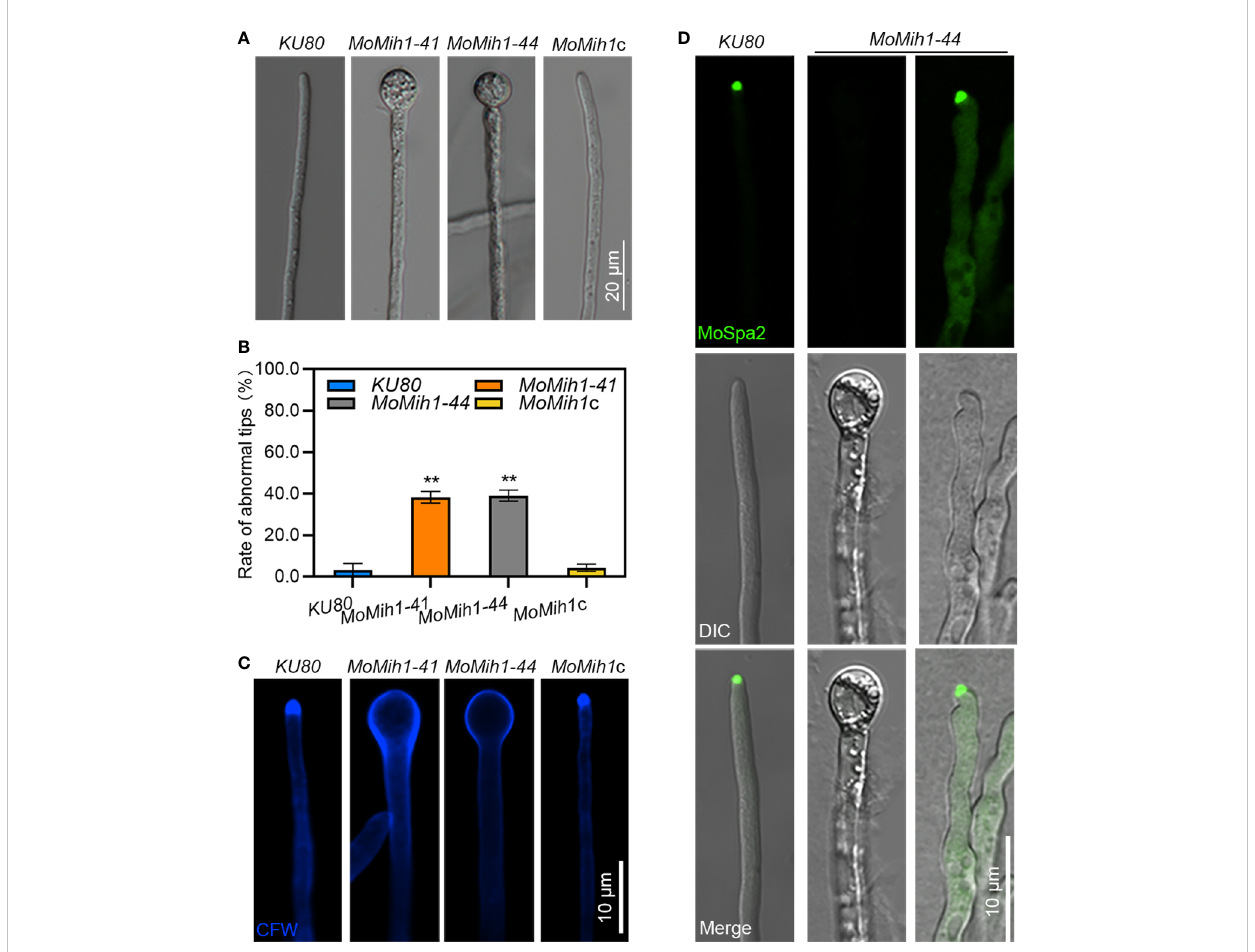
FIGURE 8 MoMih1 is required for polarized growth of M. oryzae (A) Deletion of MoMih1 resulted in the development of swollen structures at the mycelia tips. All tested strains were inoculated in liquid CM at 28°C for 48 h in darkness, and then swollen structures at the mycelia tips were photographed Bar = 20 m m. (B) Statistical analysis of abnormal structures at the mycelial tips. The rate of abnormal mycelial tips was recorded and statistically analyzed. The error bars represent the SD of three replicates, whereas “ ** ” represents a signi fi cant difference ( p < 0.01). (C) Chitin distribution on the cell wall of mycelial tips. Hyphal tips of the tested strains were stained by CFW and observed by confocal microscopy. Chitin distribution was abnormal at the swollen tips of the MoMih1 mutant. Bar = 20 m m. (D) Localization of MoSpa2-eGFP in the MoMih1 mutant. Hyphal tips of KU80 and MoMih1-44 that expressed MoSpa2-eGFP were examined by confocal microscopy. Localization of MoSpa2-eGFP to the polarisome was absent in swollen structures of the MoMih1 mutants. Bar = 20 m